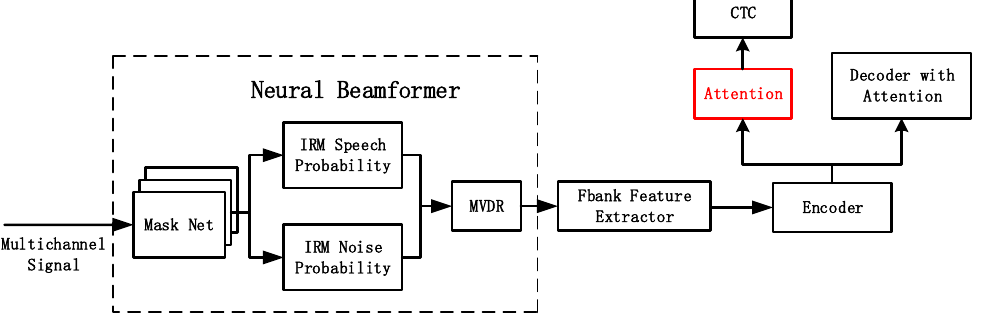
Figure 3. The multichannel time-restricted attention CTC/Attention